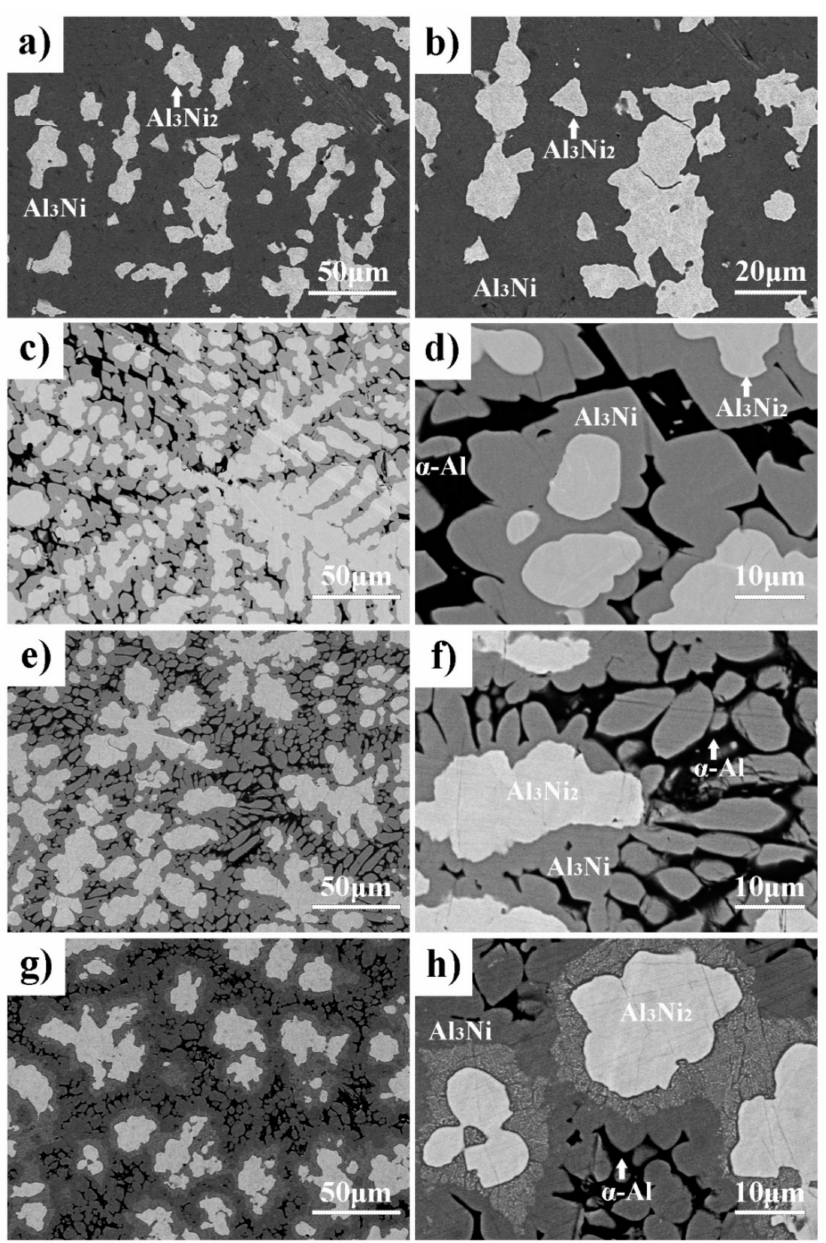
Figure 3. The microstructure of Al-47wt.%Ni alloy solidified at different pressures: ( a , b ) ambient pressure, ( c , d ) 2 GPa, ( e , f ) 3 GPa, ( g , h ) 4